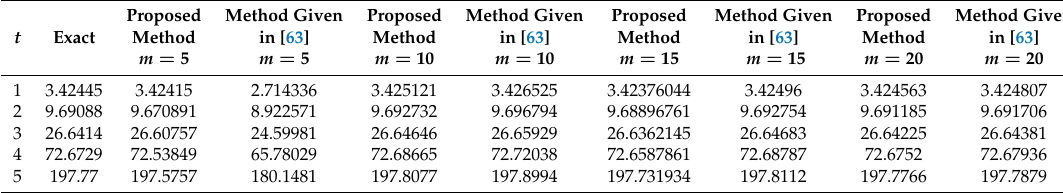
Table 9. The resulting values for Example 6, with R = 5 in some values of t.